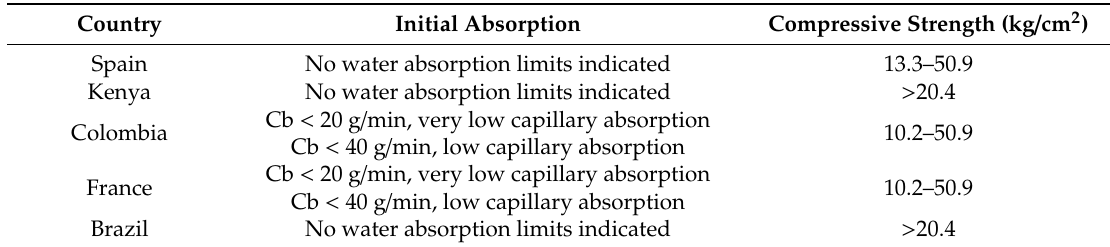
Table 7. International specifications for compressed Earth block [55].